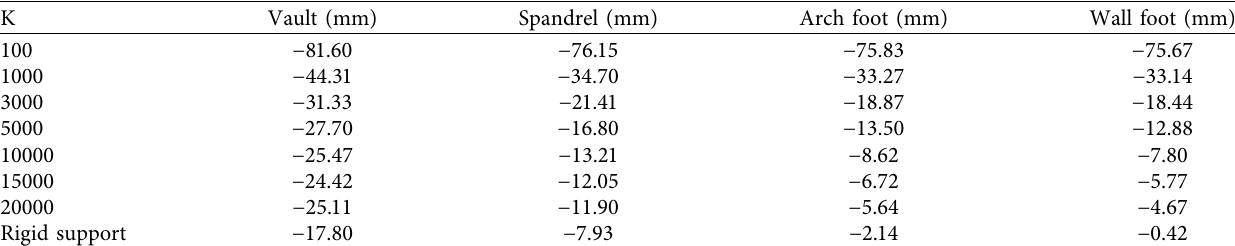
Figure 11: Time history curve of vertical displacement at study points. (a) Vault. (b) Spandrel. (c) Arch foot. (d) Wall foot. Table 9: Peak vertical displacement values of the study